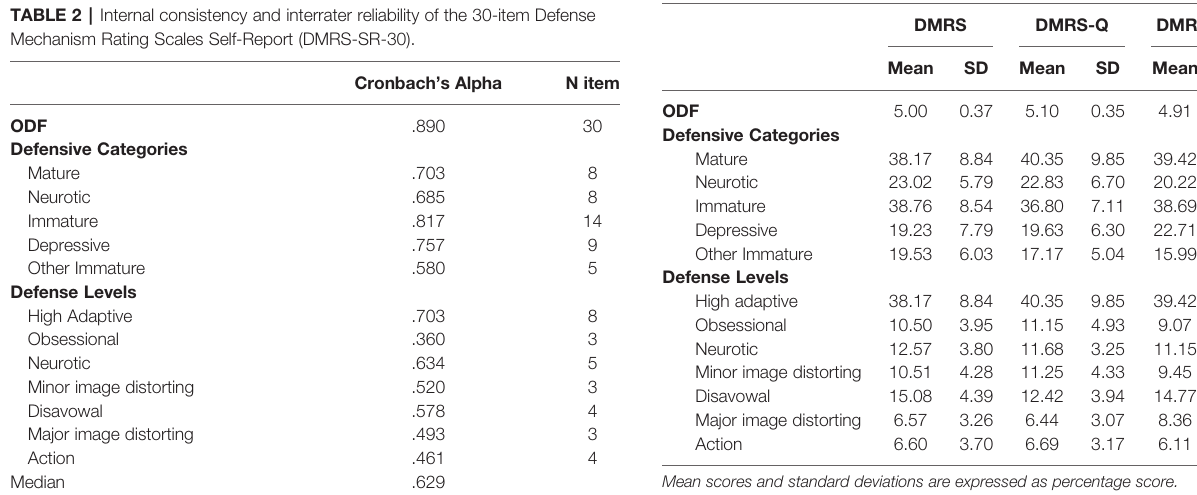
TABLE 3 | Descriptive statistics among the three Defense Mechanism Rating Scales (DMRS)